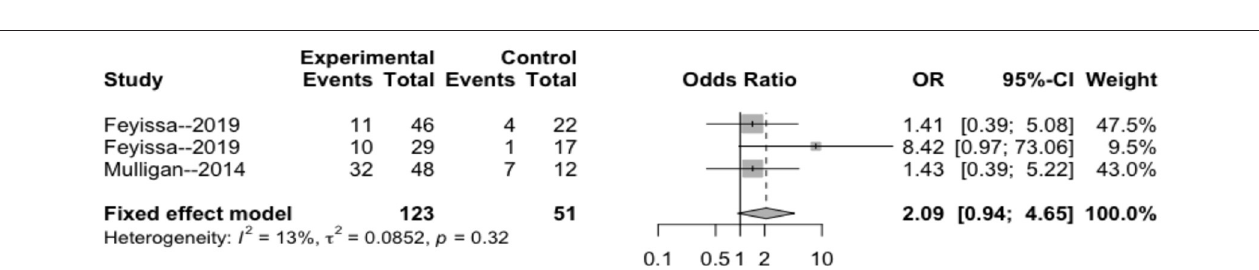
FIGURE 3 | Forest plot of the correlation between MGMT methylation and perioperative epilepsy. CI, confidence interval; MGMT, O6-methylguanine-DNA methyltransferase; OR, odds ratio.